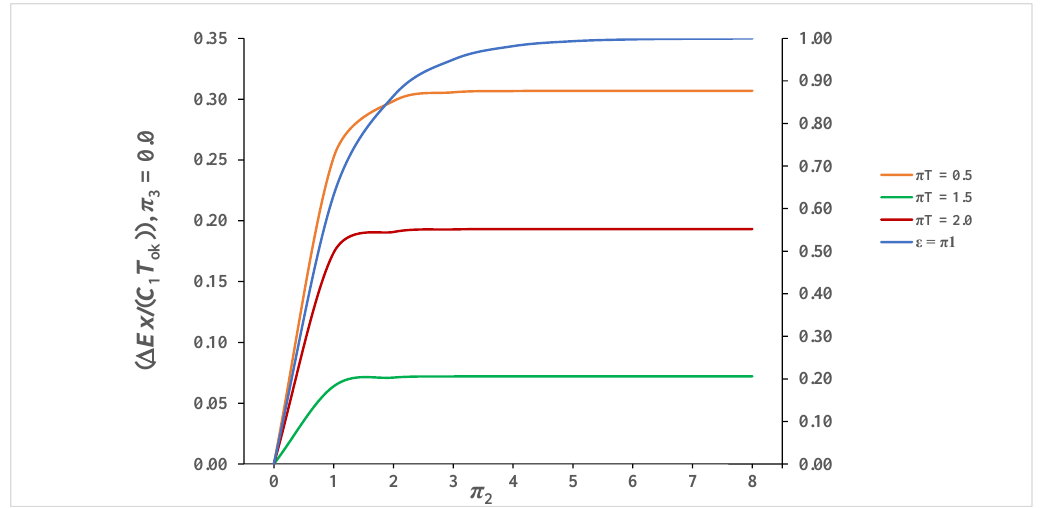
Figure 8. Dependence of exergy destruction on π 2 and π T with π 3 = 0.0.